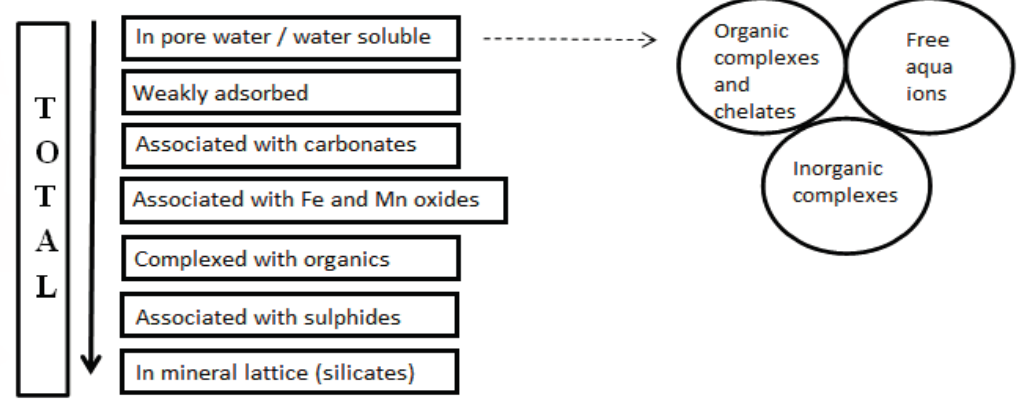
Figure 2. Chemical forms of metals in solid phases (Modified from